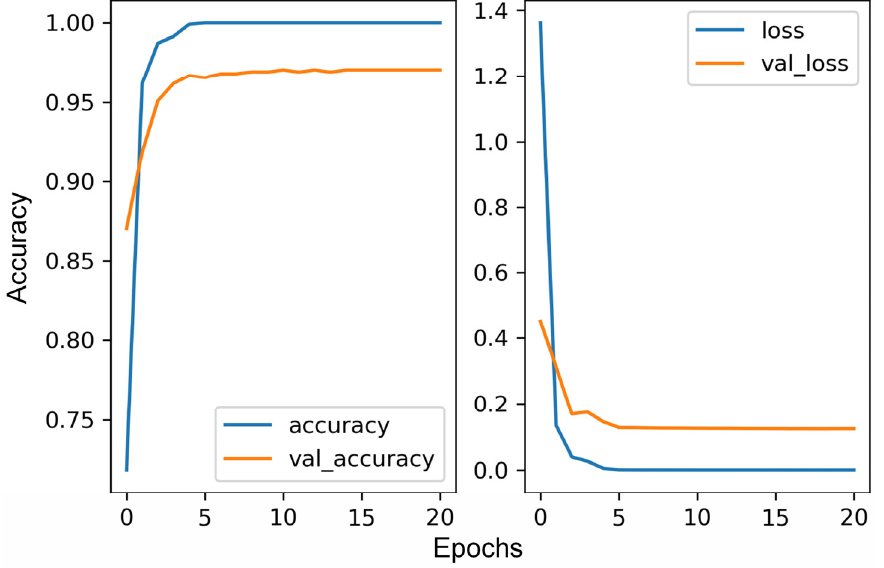
Figure 11. Learning curves of a VGG16 model (Model 3).